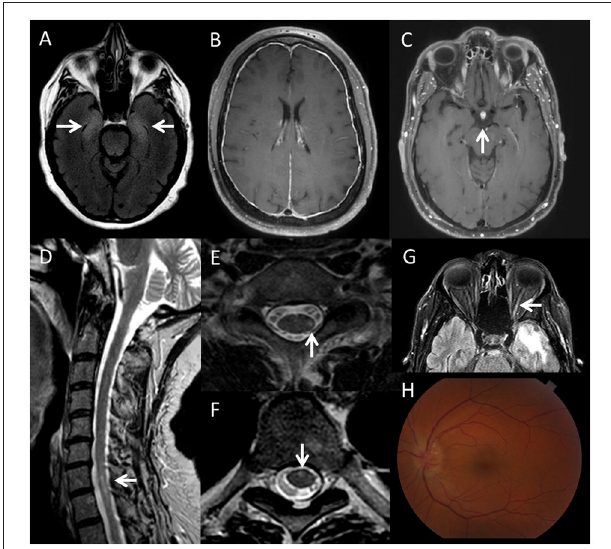
FIGURE 2 | Imaging findings in patients with neurological immune related adverse events triggered by immune checkpoint inhibitors. (A) Axial brain MRI, fluid attenuation inversion recovery (FLAIR) sequence, showing bilateral T2-hyperintensity of the medial temporal lobes (right more than left), in a patient with limbic encephalitis associated with an unclassified neural-specific antibody, after treatment with nivolumab for melanoma. (B) Axial brain MRI, T1 post-gadolinium sequence showing dural enhancement in a patient with meningitis during treatment with nivolumab for sarcoma. (C) Axial brain MRI, T1 post-gadolinium sequence, showing enhancement of the hypophysis in a patient with hypophysitis after atezolizumab treatment. (D) Sagital T2 cervical spine MRI, (E) axial T2 cervical spine MRI and (F) axial T2 thoracic spine of a patient who developed short-segment (multiple sclerosis-like) spinal cord lesions (left lateral cord at C7–T1 and ventral cord at T5–T6) after treatment with nivolumab and ipilimumab for melanoma. (G) Axial FLAIR brain MRI showing T2 hyperintensity of the left optic nerve in the same patient. (H) Optic disc edema in a patient with bilateral optic neuritis triggered by atezolimumab treatment for small cell lung cancer, associated with positive CRMP-5